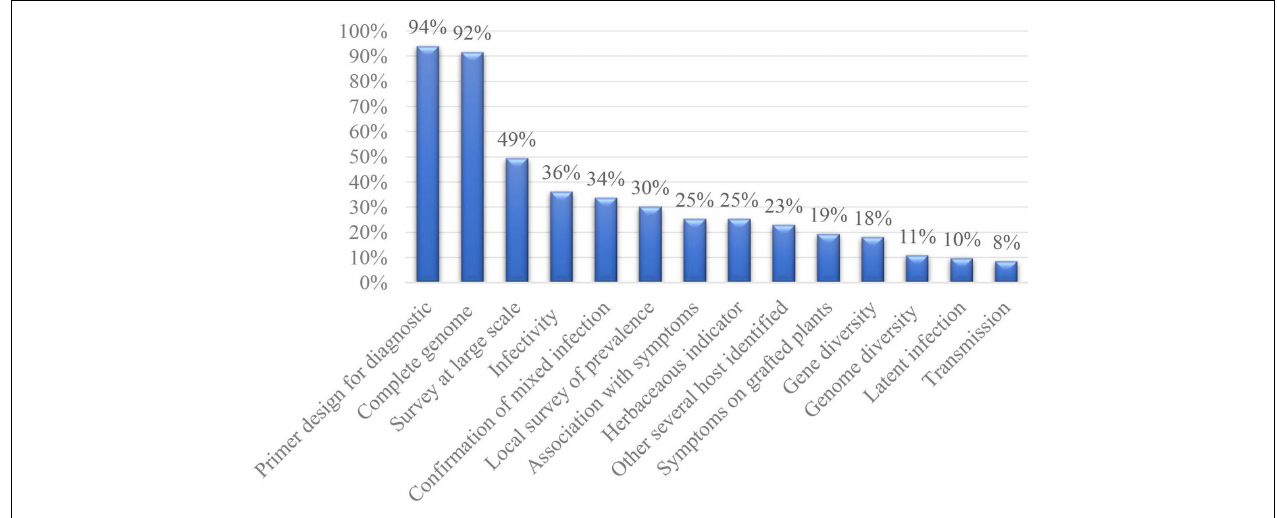
FIGURE 1 | Scientific information added when a new fruit tree viral species is